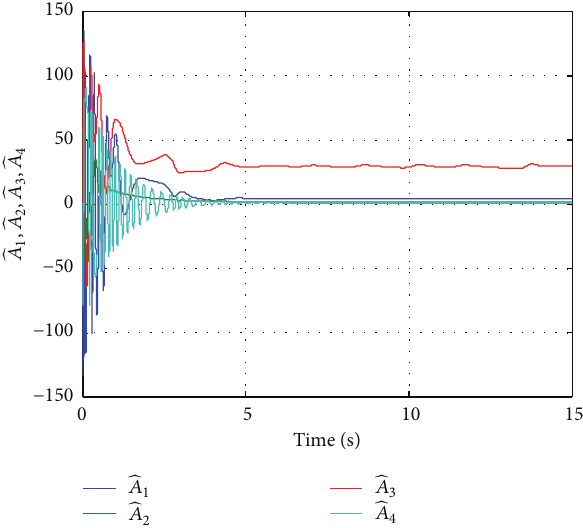
Figure 10: Time histories of estimated parameters for Case